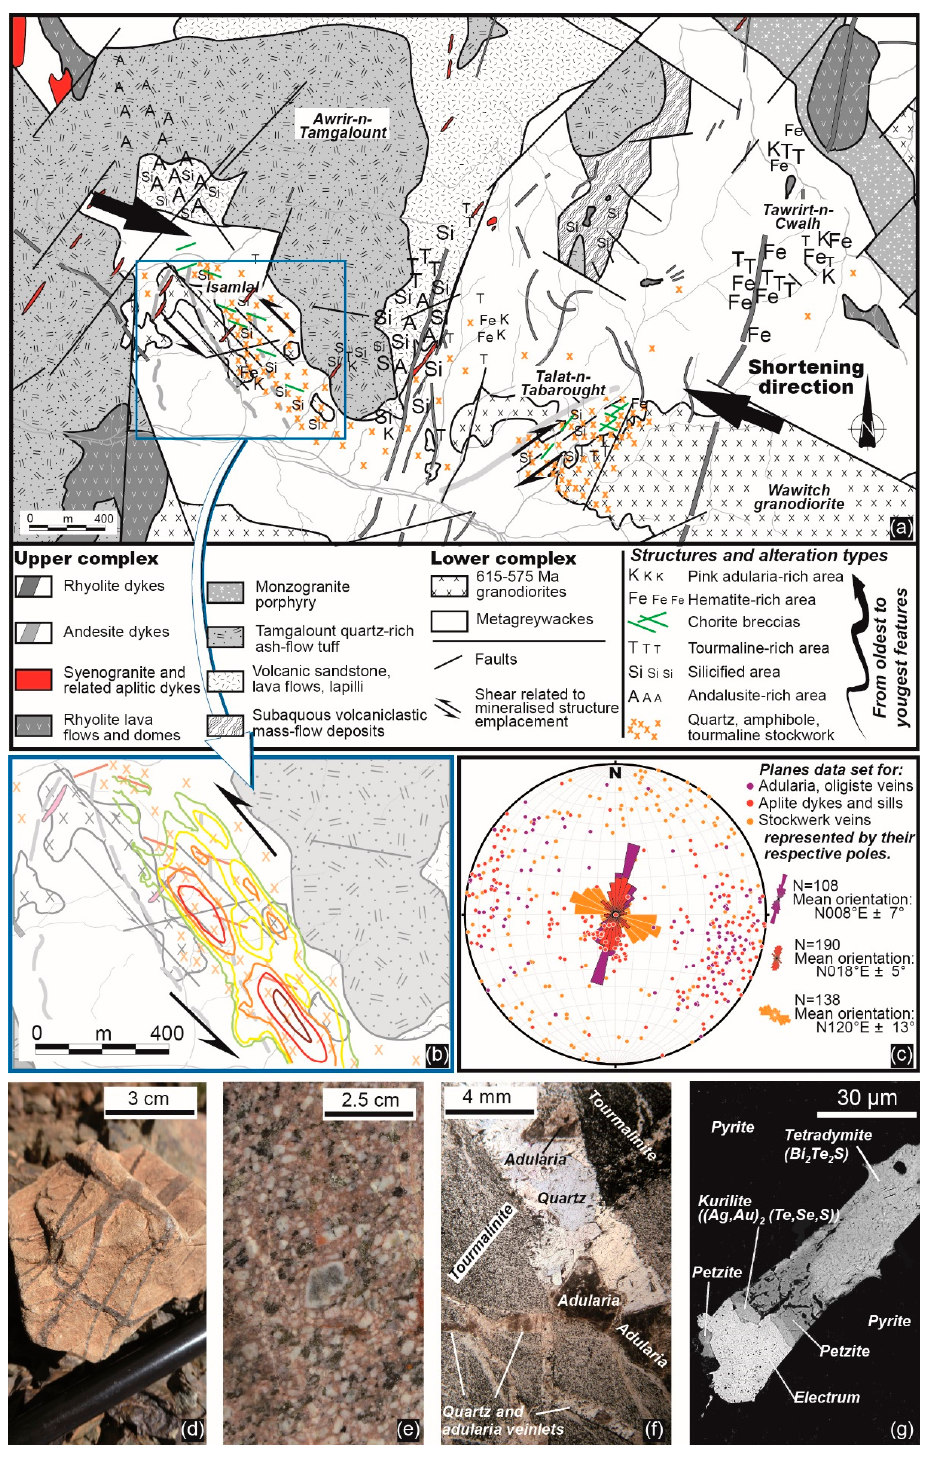
Figure 9. Main features of the Qal’at Mgouna deposit types [47,158]. ( a ) Detailed map of the Au( – Cu – Mo – Ag – Te – Bi) Qal’at Mgouna district (from Tuduri [47]). Note that the kinematics shown by shear zones are consistent with a WNW – ESE direction of shortening. ( b ) Kriging interpolation revealed that gold anomalies are correlated with both the quartz stockwork and the NW – SE faulted corridor in the Isamal porphyry deposit. The red colour is indicative of the highest Au grades [158]. ( c ) Stereoplots of structural orientations data for: the quartz stockwork related to the porphyry stage (mean orientation N120 ◦ E); the aplitic dykes and sills related to the alkali–syeno–granite stocks